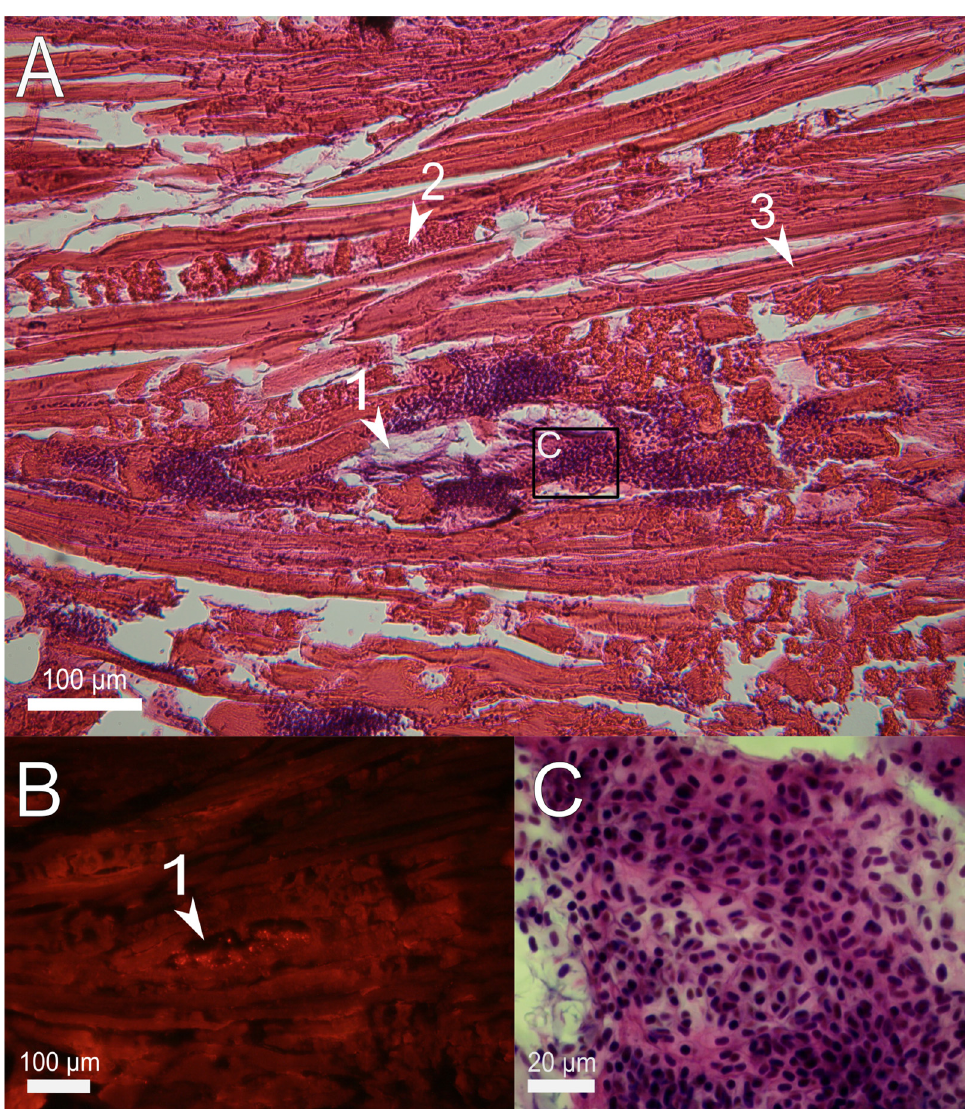
Figure 2. Sagittal histological section of D. rerio muscles 6 h after the injection of 2.7% PAAH + PMs. ( A ) histological section of the injection site ( × 10), H&E stain; ( B ) fluorescence of the unstained histological section in the red channel indicates microcapsules loaded with SNARF-1; ( C ) enlarged image of the region from A ( × 100) showing the aggregation of spilled erythrocytes (hematoma); 1, PAAH + PMs; 2, damaged myofibrils; 3, normal myofibrils.